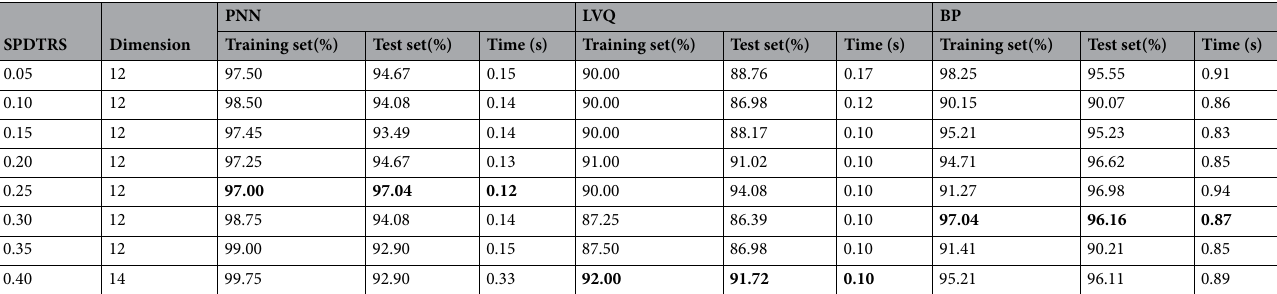
Table 2. Comparison of accuracy and time of different ξ values. The bold font in the table is the parameter value with better effect selected from each